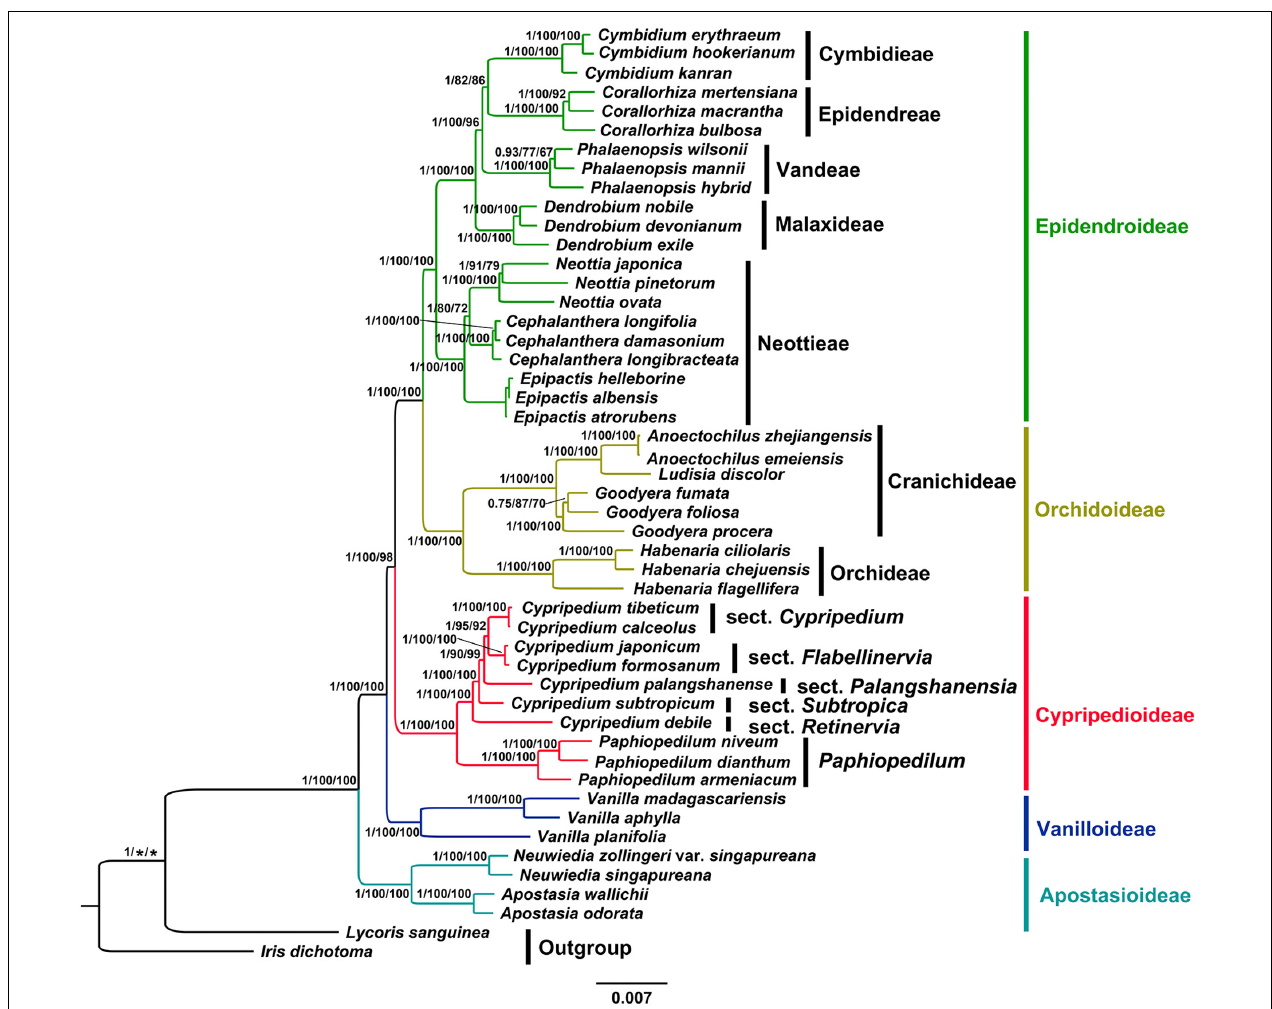
FIGURE 5 | Phylogram depicting the relationships of the plastid CDSs of 47 different Orchidaceae species using ML method. Numbers associated with nodes indicated Bayesian posterior probabilities (PP), maximum likelihood (BS ML ) and maximum parsimony (BS MP ) bootstrap values, respectively. The PP on the left, BS ML in the middle, BS MP on the